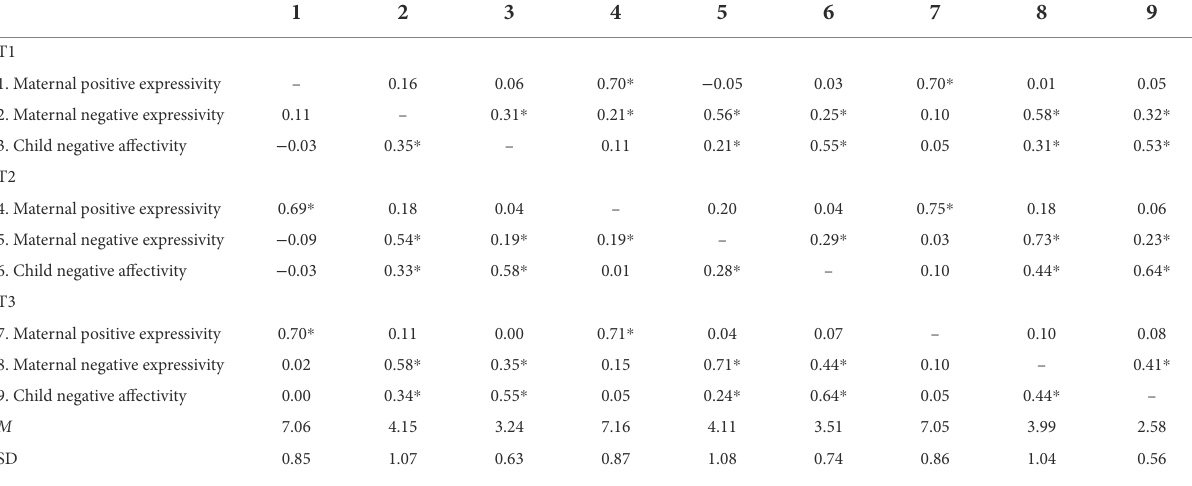
TABLE 1 Means, standard deviations, and correlations among study